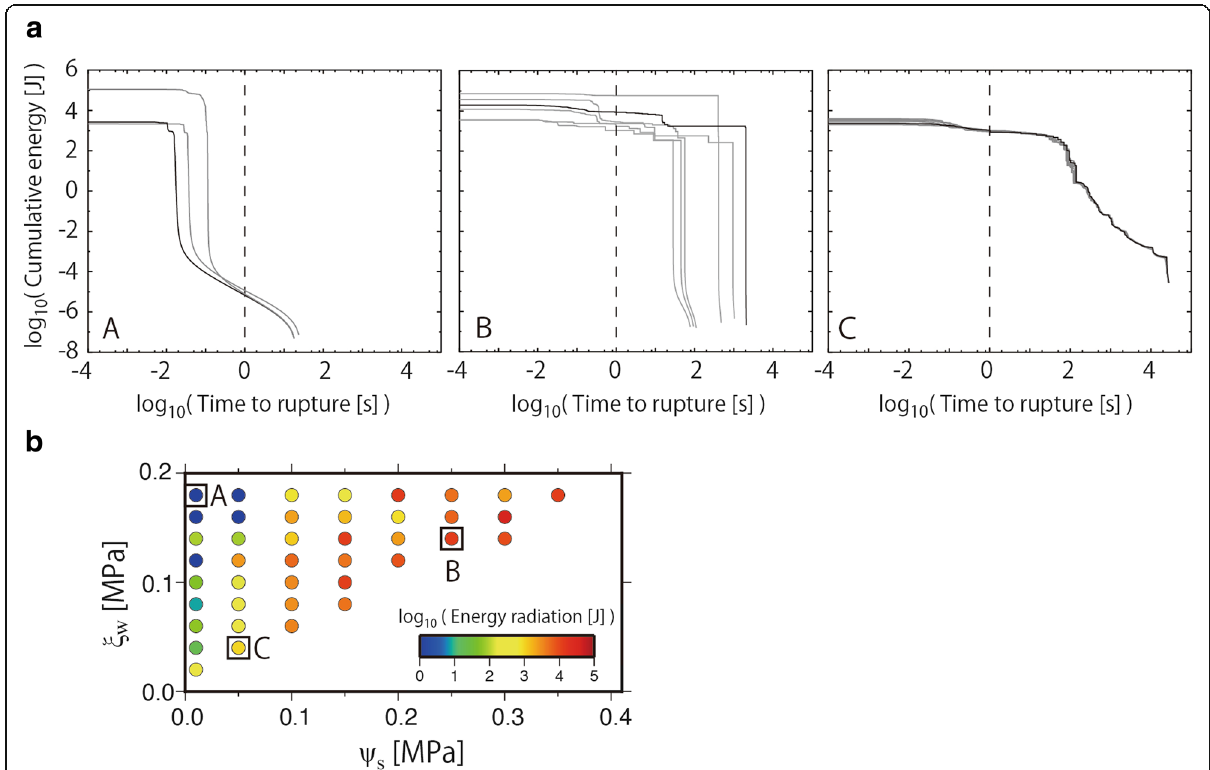
Fig. 7 Parameter studies of energy radiation. a Cumulative energy radiation plotted against the time remaining before the mainshock for parameter sets A – C. Black curves represent events presented in Fig. 3. Grey curves are for other mainshocks shown in Fig. 2. b Results of parameter studies. The color indicates the amount of cumulative energy at 1 s before the mainshock. Parameter sets A – C shown in a are denoted by squares